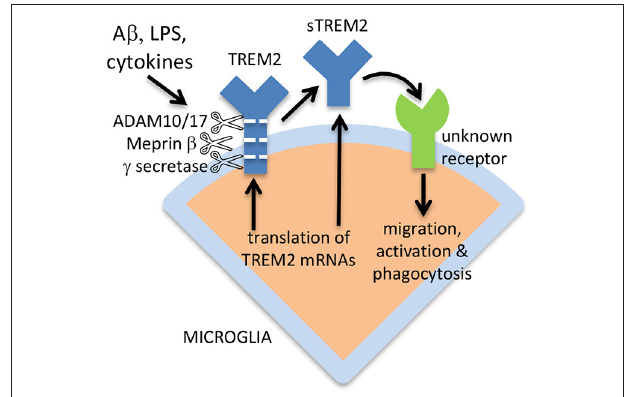
FIGURE 1 | Release of sTREM2 from microglia, and activation of microglia by sTREM2. sTREM2 may be generated by ADAM10/17 or meprin β proteolysis of full-length TREM2, or from expression of an isoform lacking the transmembrane domain. γ secretase can cleave the remains of TREM2 within the membrane to degrade it. Released sTREM2 can chemoattract and activate microglia via unknown